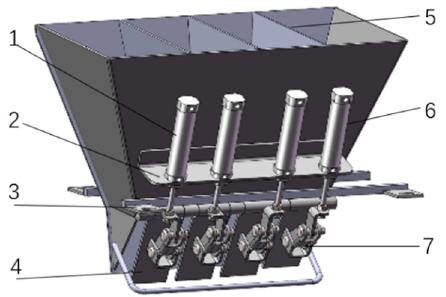
Figure 3. Feeding mechanism. 1. feeding cylinder, 2. install plate, 3. connector, 4. limit plate, 5. partition plate, 6. buffer box, 7. rotation shaft.